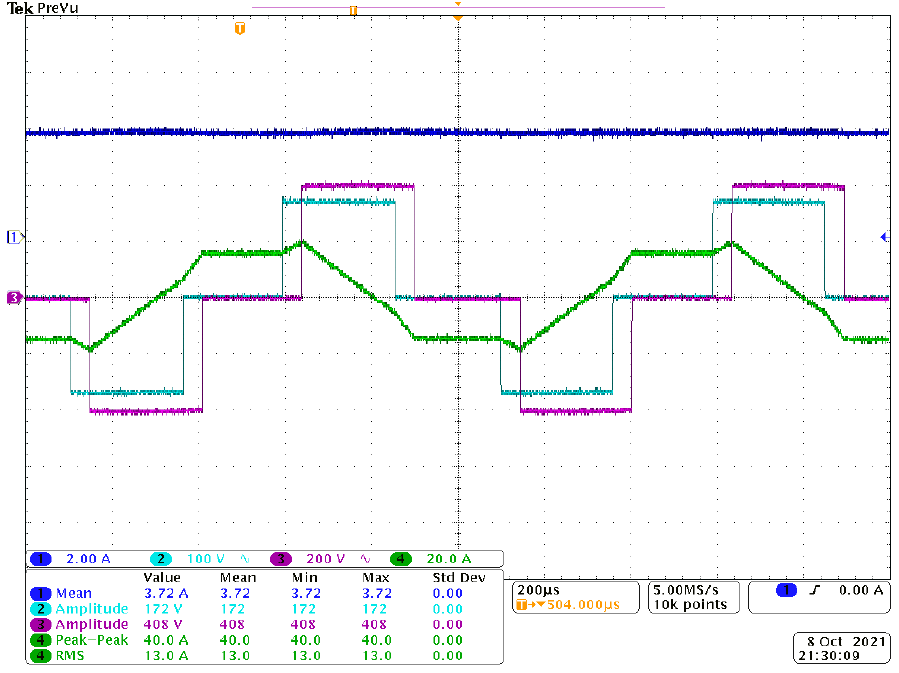
Figure 22. DAB operation at medium power under the DPS-based PLM.